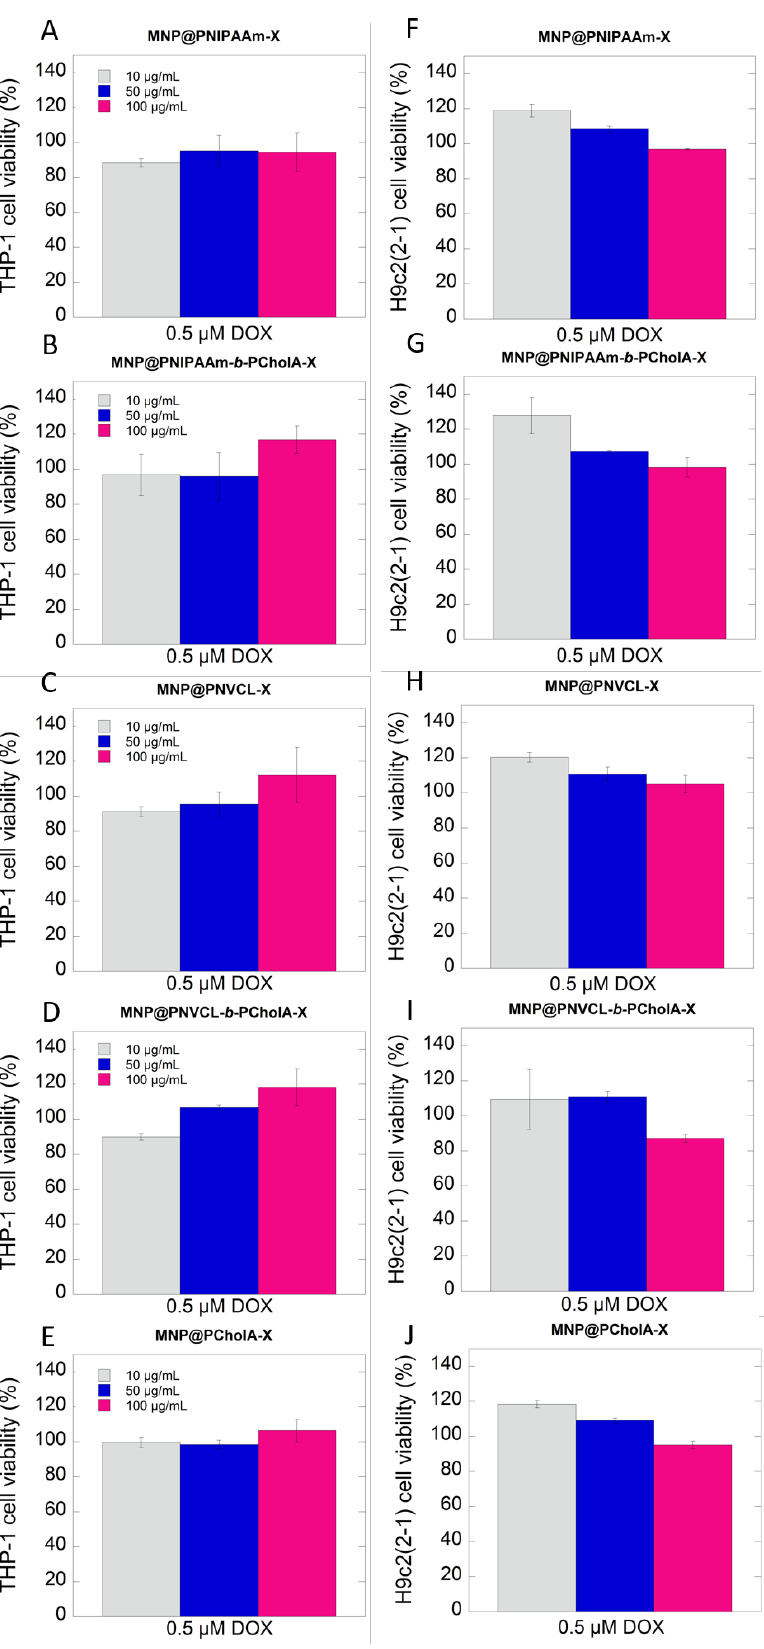
Figure 5. Lack of toxicity of the mixtures of DOX and polymer – iron oxide hybrids against repre- sentative immune THP-1 cells ( A – E ) and cardiomyocyte H9c2(2-1) cells ( F – J ).